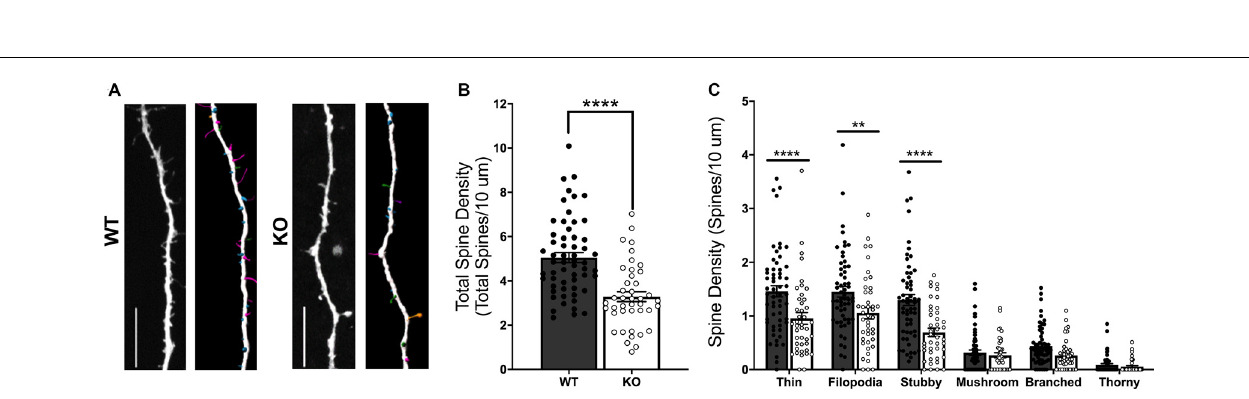
FIGURE 2 | Dendritic spine analysis of WT and Fmr1 knockout (KO) striatal MSNs at day in vitro (DIV) 14 ( A ; scale bars 10 µ m). KO cells have a significant deficit in total dendritic spine density ( B ; unpaired t -test), as well as deficits in thin, filopodia, and stubby spine type densities ( C ; two-way RM ANOVA). Significant Bonferroni comparisons are indicated (** p < 0.01, **** p < 0.0001); data shown are mean ±